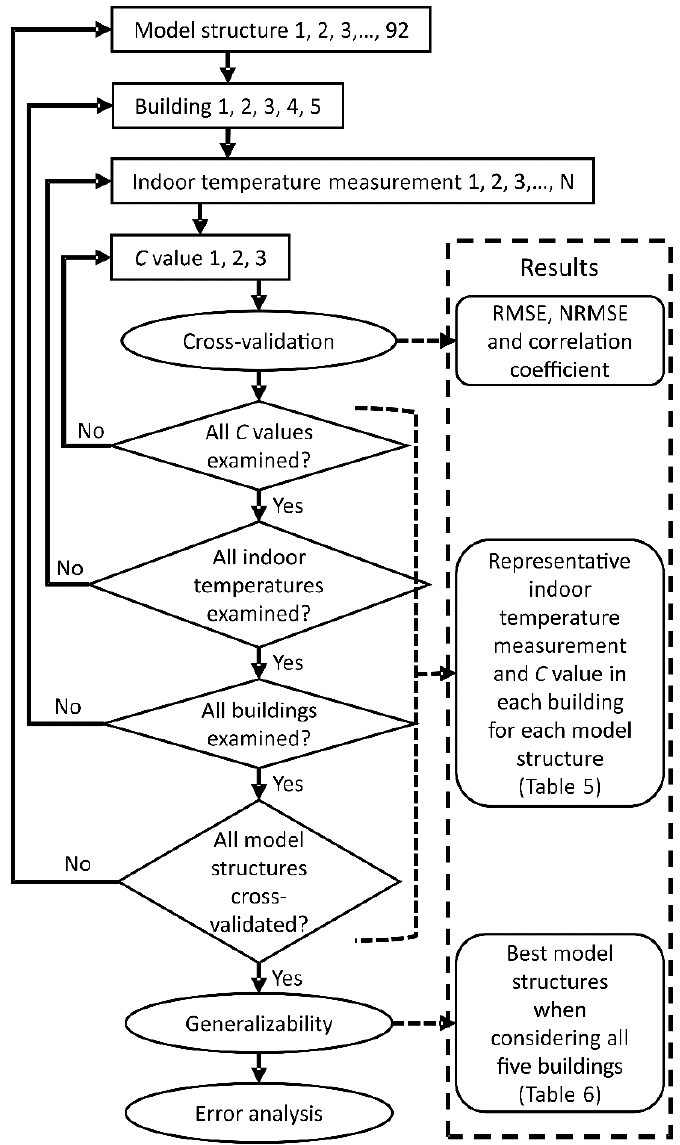
Figure 3. An overview of the model identification and validation process. Cross-validation of the model structures is carried out for each building with all the combinations of indoor temperature measurements and C values and RMSE, NRMSE and r are calculated. For each model structures, the representative indoor temperature and C value combination is determined based on NRMSE and r. Generalizability is studied after all model structures are cross-validated in all of the buildings. The best model structures are determined based on RMSE and